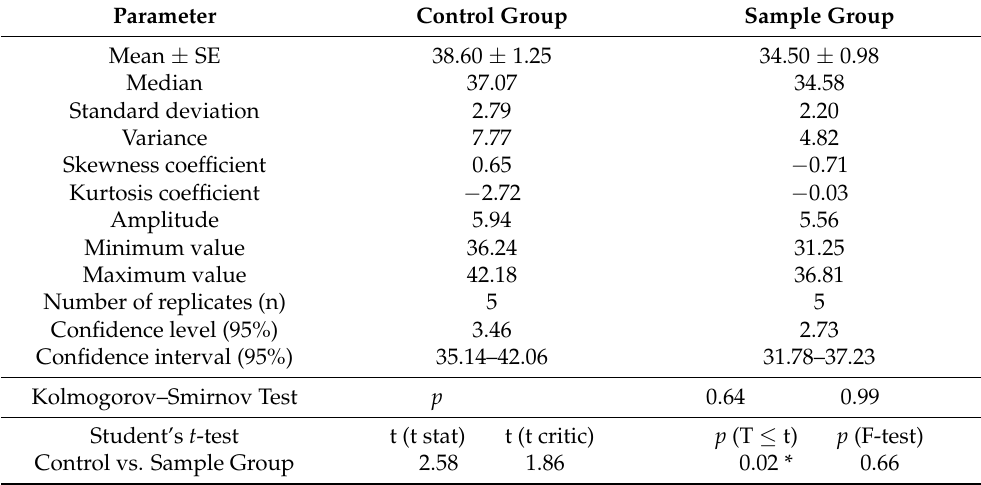
Table 7. Mean corpuscular hemoglobin concentration in a given volume of erythrocytes (MCHC as